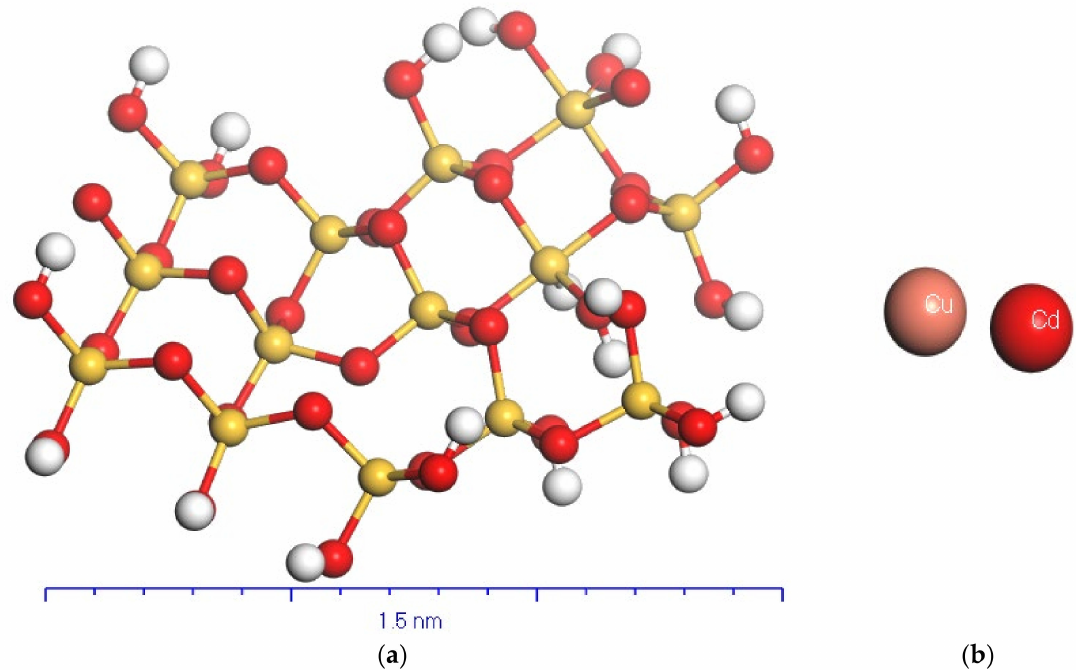
Figure 9. Cleaned hydrated silica structure: ( a ) Si (yellow), O (red), H (white), and ( b ) Cu and Cd ions. An adsorption locator for both Cu 2+ and Cd 2+ on the silica surface was performed using the universal forcefield and the Ewald summation method, with 100,000 loading steps and one heating cycle. The interaction energy was measured at 11,000 steps, with an incremental 1000 steps each. The framework charge contains 48 electrons/cell with a maximum of five ions for each Cu 2+ and Cd 2+ . The loadings of both ions are shown in Figure 10, where both ions demonstrate homogeneous uptake within the silica